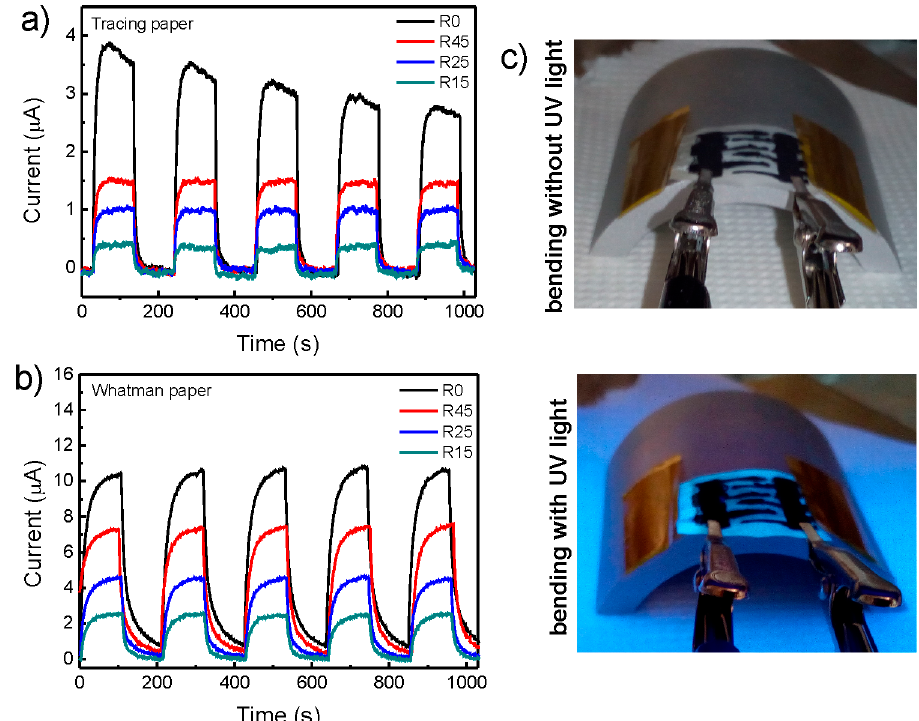
Figure 12. Flexibility cycling behavior of cellulosic ZnO nanorods UV sensors grown on ( a ) tracing paper and ( b ) Whatman paper as a function of a curvature radius of 45, 25 and 15 cm (R45, R25 and R15, respectively). R0 is the measurement with no bending. ( c ) Photograph of cellulosic ZnO nanorods UV sensor, in a bending state, without and with UV light. Table 2. UV Sensor parameters measured as a function of a curvature radius of 45, 25 and 15